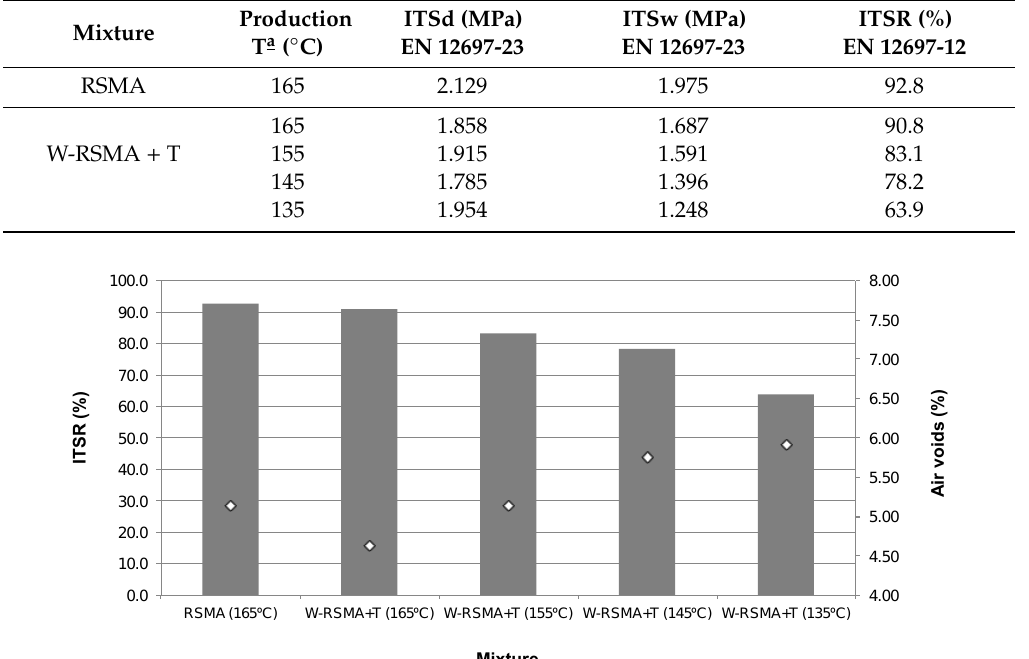
Table 7. Volumetric characteristics of the mixtures.